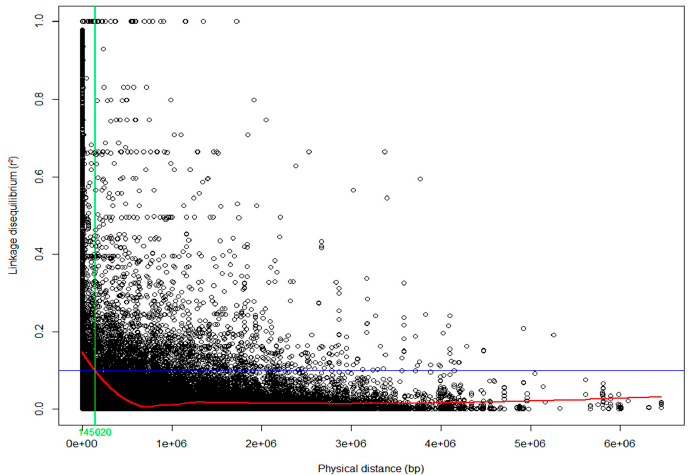
Figure 3. Linkage disequilibrium (LD) decay in the S. platyclados half-sib progeny population. Pairwise LD ( r 2 ) values plotted against the physical distance (bp) between all pairs of single nucleotide polymorphisms (SNPs). The trend line of the nonlinear regressions against physical distance is given by the red line. The horizontal blue and vertical green lines represent the critical value of r 2 (0.1) and LD decay value,